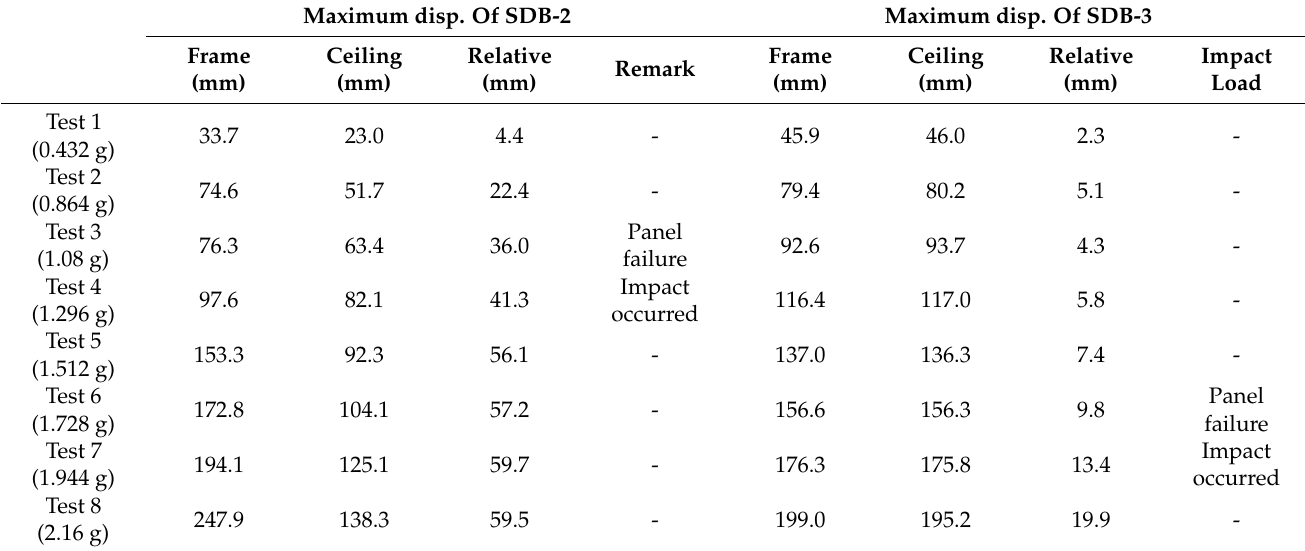
Table 6. Maximum frame displacement, ceiling displacement, and the relative